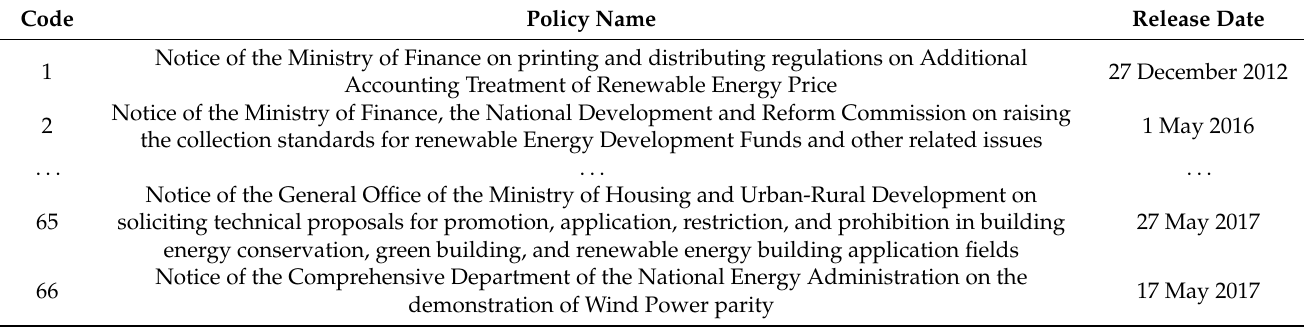
Table 1. Examples of Policy